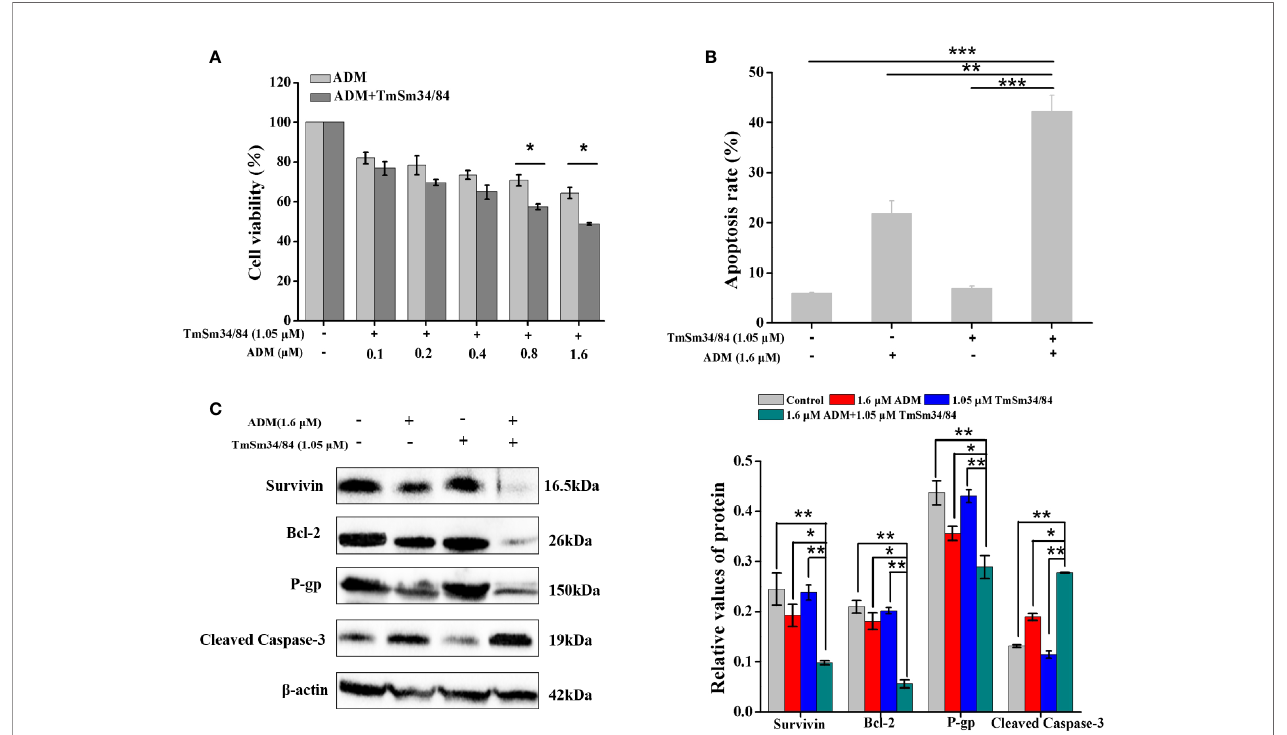
FIGURE 10 | The effect of TmSm34/84 on the drug resistance against CSCs. (A) Viability of CSCs was measured by incubating with TmSm34/84 (1.05 m M) plus ADM of different concentrations (0, 0.1, 0.2, 0.4, 0.8, and 1.6 m M) for 24 h, respectively. (B) The apoptosis-inducing effect of ADM (1.6 m M), TmSm34/84 (1.05 m M), and their combination on CSCs as tested with fl ow cytometry, respectively. Bar diagram depicting the total percentage of apoptotic cells. (C) The effects of ADM, TmSm34/84, and their combination on the protein expression in CSCs were detected by Western blot, respectively. Data were expressed as mean ± SD ( n = 3). * P < 0.05, ** P < 0.01, and *** P <